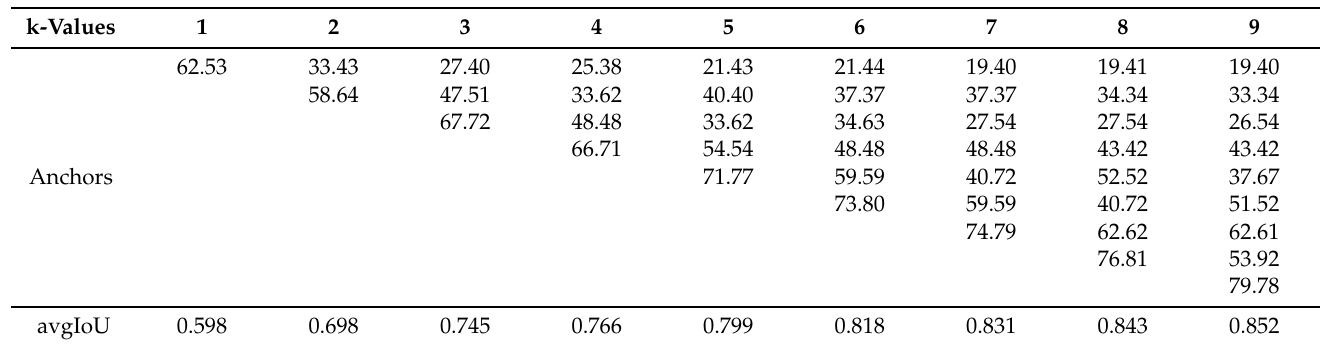
Table 2. The relationship between the number of anchors and avgIoU is obtained based on the k-means++ clustering